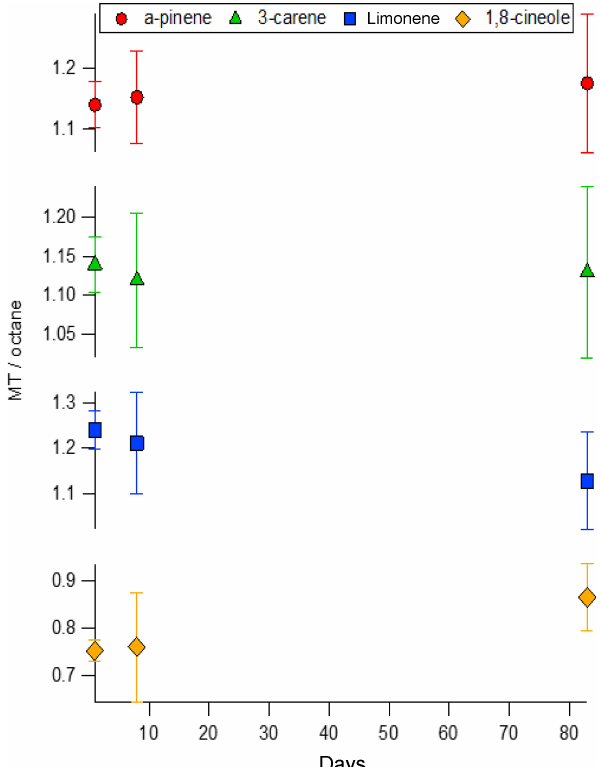
Figure 6. The short-term stability of mixture BB decanted into a SilcoNert 2000 ® treated canister compared as a ratio of the area of each monoterpene normalised relative to the n -octane internal standard. Error bars are included to account for the relative standard deviation of the mean ( k =